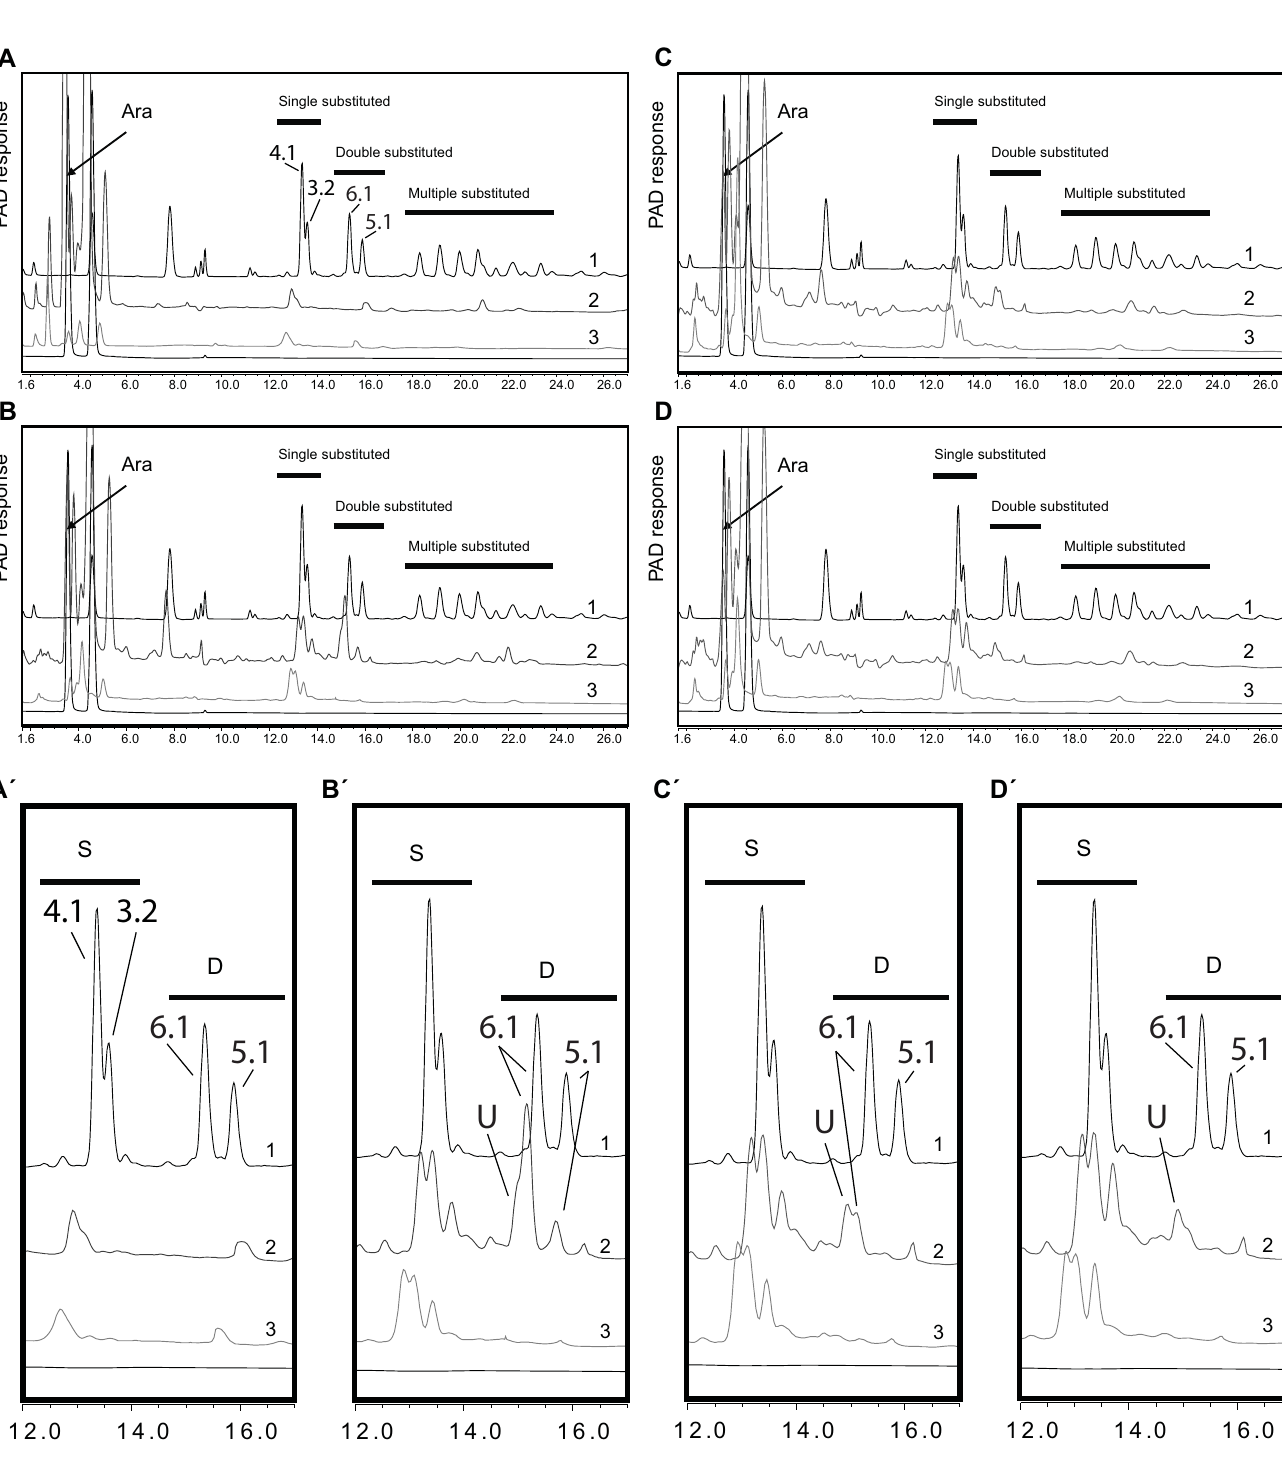
Fig 3. HPAEC chromatogram of endoxylanase pre-digested WAX incubated with concentrated compost extract. PII extract (A) and extract of compost colonized by A15 (B), HGH43-1 (C), and HGH43-2 (D). Endoxylanase pre-digested WAX without compost extracts (1), with concentrated compost extract (2), and compost extract without WAX-oligomers added (3) are shown in each panel. The line closest to the x-axis shows the retention time of arabinose and xylose at 3.5 and 4.5 min, respectively. Each sample is representative for a biological triplicate. The chromatogram is magnified from retention time 12–16.5 min (A’, B’, C’, and D’) for each sample where single and double substituted arabinoxylan oligomers are indicated with S and D, respectively. Specific xylosyl oligomers substituted with a single arabinosyl are indicated with 4.1, 3.2 in A and A’. Xylosyl oligomers with a double arabinosyl substitution are indicated with 6.1 and 5.1 in A, A’, B’, C’, and D’. An unknown oligomer is indicated with U in B’, C’, and D’. Chromatograms of compost extract or compost extract incubated with WAX were shifted 10–30 sec to the left as compared to endoxylanase hydrolyzed WAX.